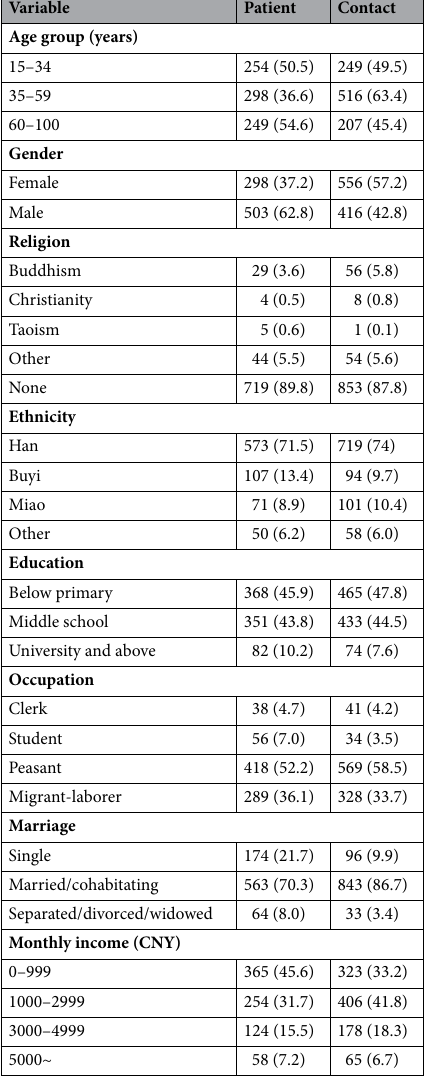
Table 1. Socio-demographic characteristics of subjects of the study on the gradient association of tuberculosis on developing diabetes mellitus among households with a tuberculosis case, 2020 (n, %). CNY Chinese Yuan.